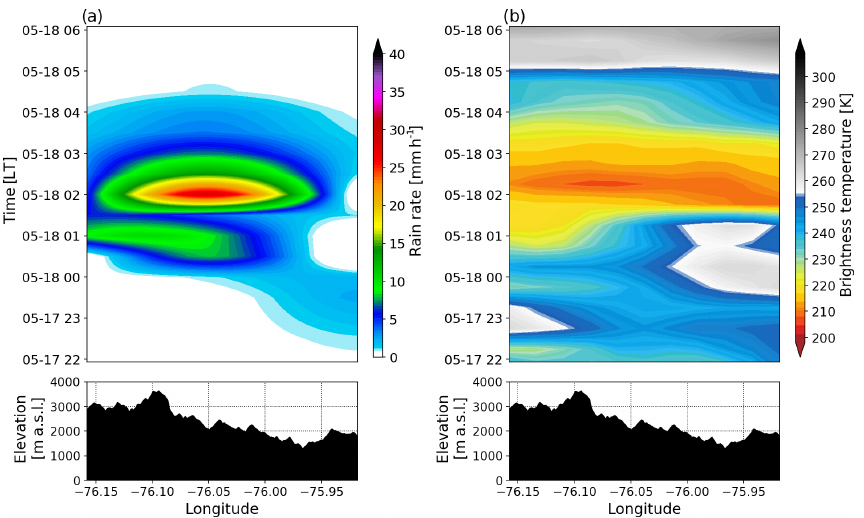
Figure 17. Longitude–time Hovmöller diagram at 6.00535 ◦ N in the same time interval as before for (a) IMERG interpolated rainfall rate, and (b) GOES-13 brightness temperature. The terrain profile at 6.00535 ◦ N is shown below the Hovmöller